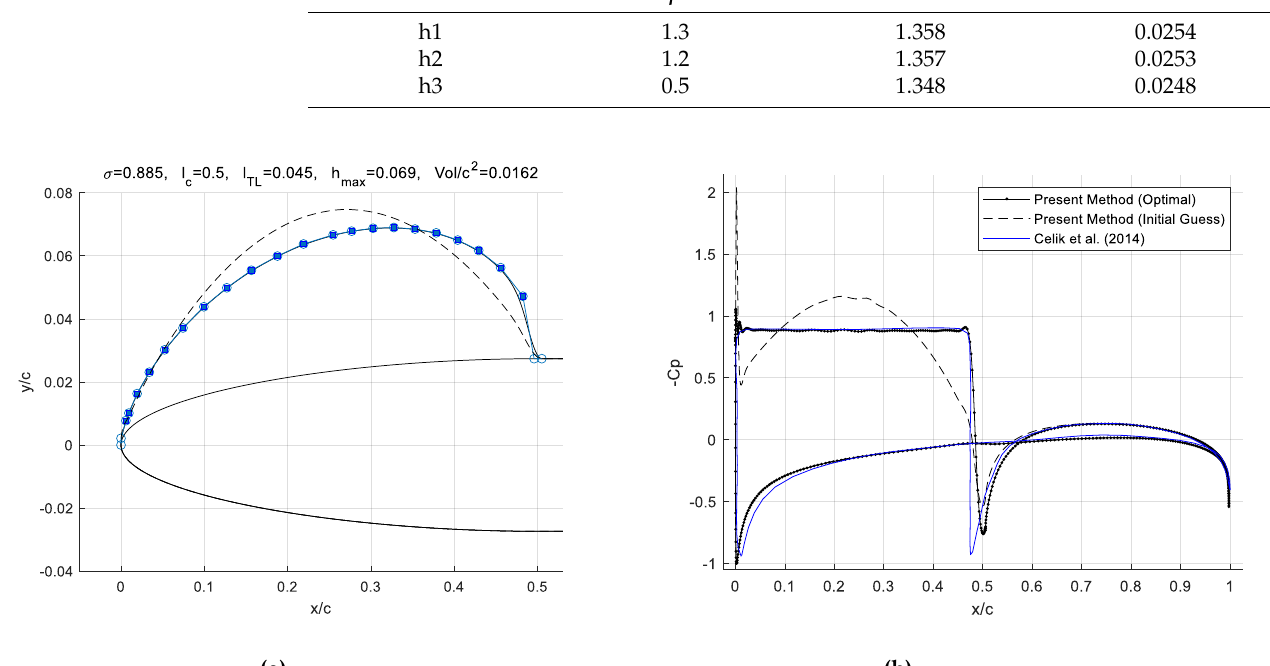
Figure 7. Comparison between the present method and results found in the work of [18]. ( a ) Initial and final cavity shape for NACA16–006 with lc = 0.5 at a = 4 ◦ . The squares represent the control points of the B-spline representation. ( b ) Pressure coefficient for the partially cavitating NACA16–006. Table 1. Effects of cavity initialization on the solution.